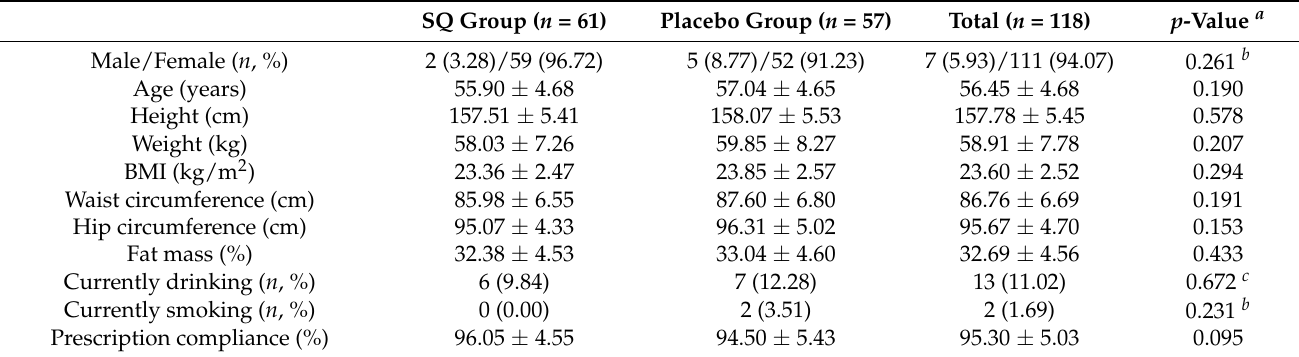
Table 2. Baseline information on